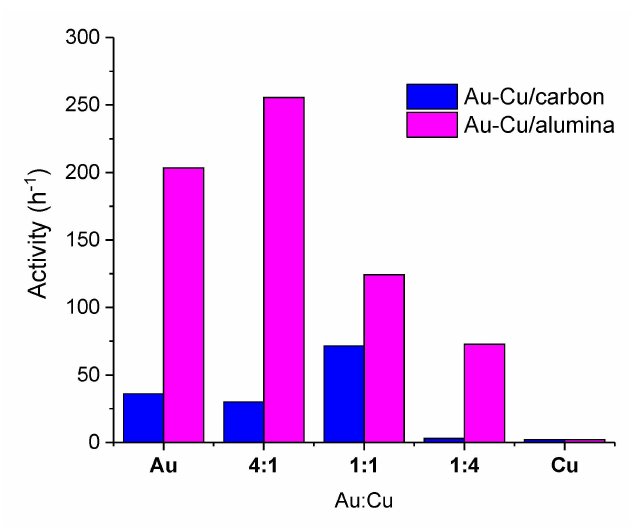
Figure 10. Initial activity (h − 1 ) (mol converted per mol of metal per hour) calculated at 1 h of reaction as a function of the Au / Cu molar ratio. Comparison between alumina- and carbon- supported Au and Au-Cu catalysts.